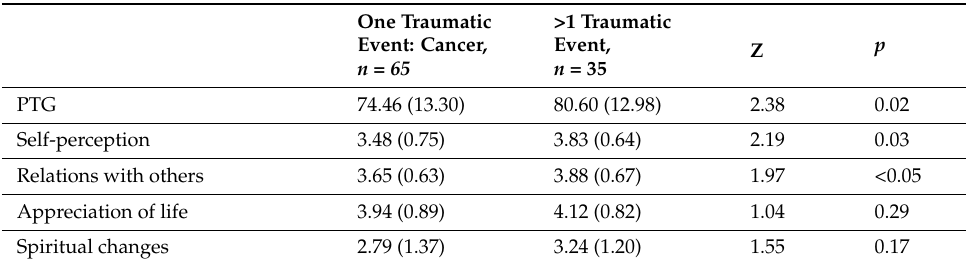
Table 7. Differences in post-traumatic growth and its components in women experiencing one and many traumatic events (Mann–Whitney U